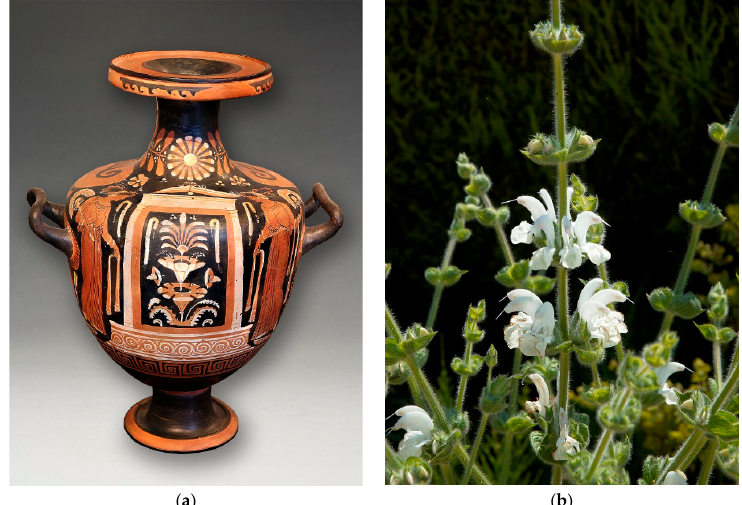
Figure 22. ( a ) Basel, Antikenmuseum S 26 Apulian hydria, Ganymede Painter, ca. 330–320 B.C. Naiskos containing flowers flanked by women with fans and fillets. Photograph © Antikenmuseum Basel und Sammlung Ludwig. ( b ) Silver sage ( Salvia argentea ). Photograph courtesy of Wikimedia Commons.